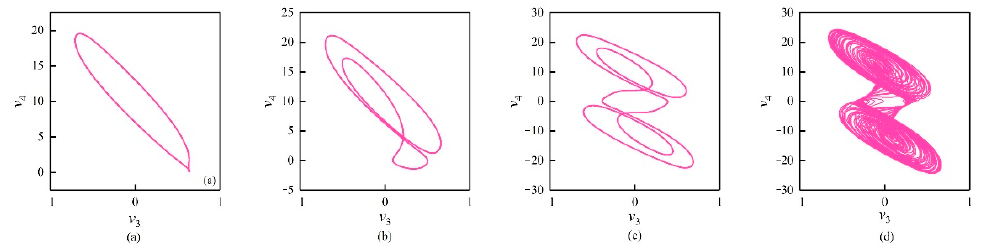
Figure 8. Attractor trajectories with the different β 2 , where q = 0.8, β 1 = 0.2, ( a ) β 2 = 6.2; ( b ) β 2 = 8.2; ( c ) β 2 = 10.3; ( d ) β 2 = 13.5.